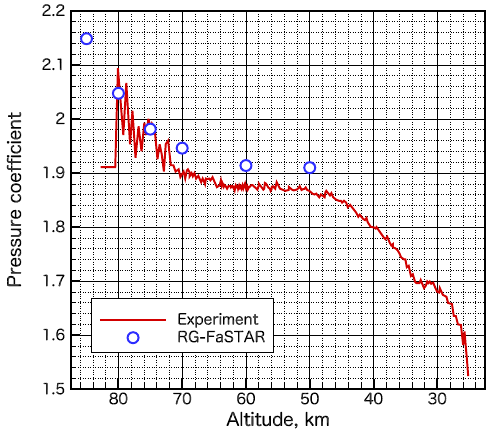
Figure 7. Comparison of the pressure coefficient at stagnation at the vehicle’s front between the flight experiment and numerical